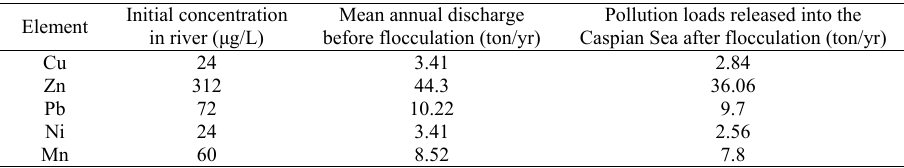
Table 6: Load of dissolved metals released into the Caspian Sea before and after flocculation process